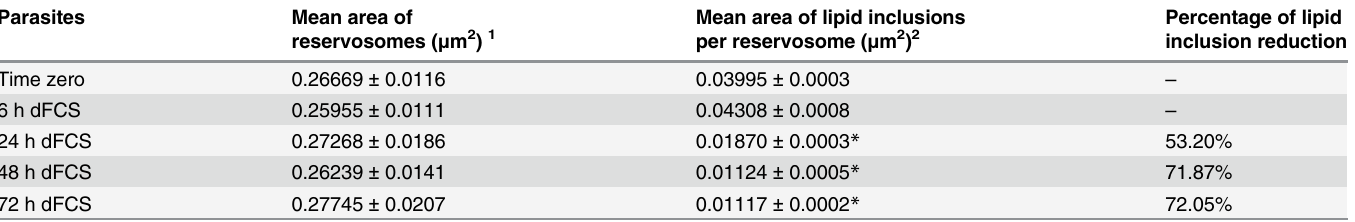
Table 1. Morphometric analysis of the area of reservosomes and the area occupied by lipid inclusions inside them in epimastigotes cultivated in LIT medium supplemented with 10% dFCS. Parasites